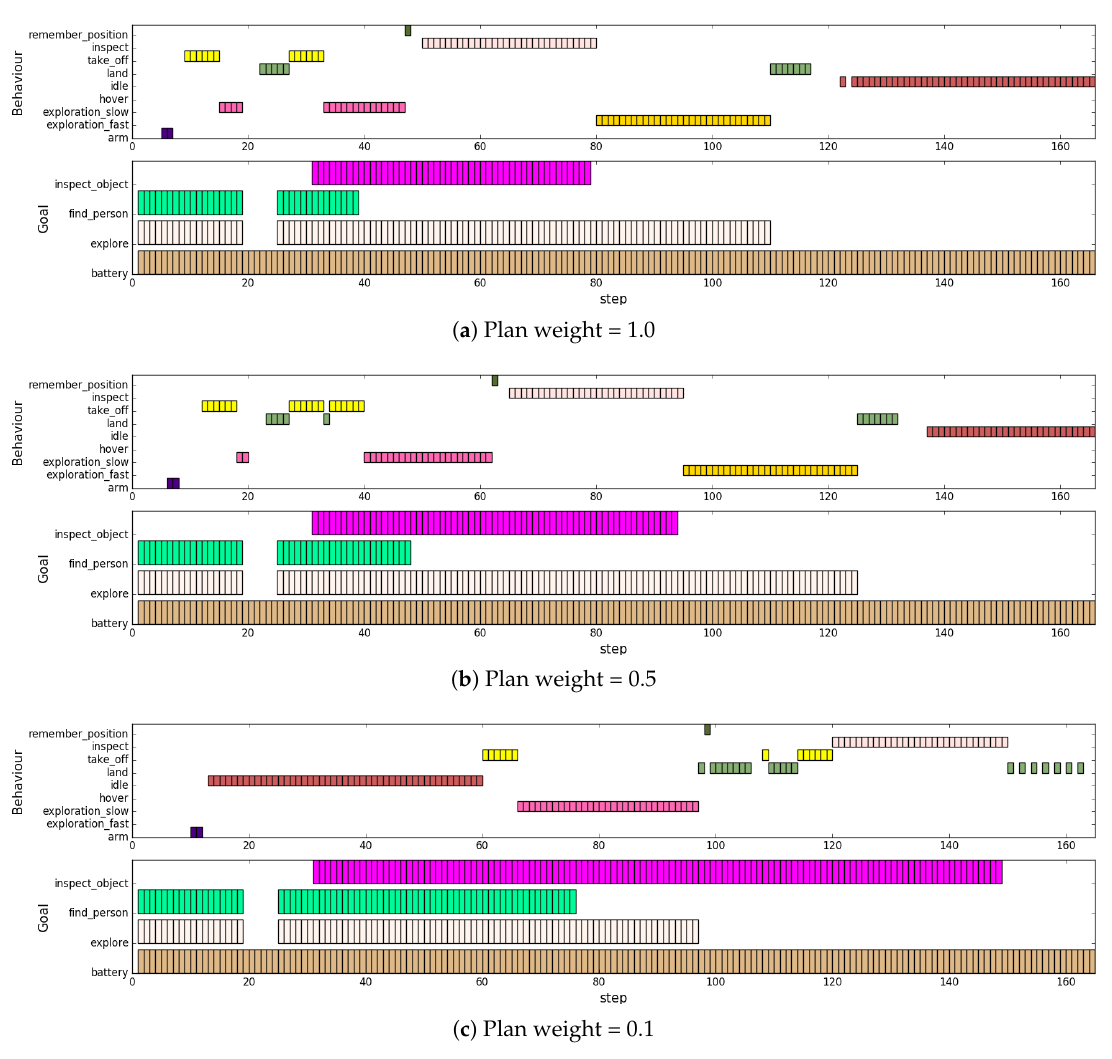
Figure 14. Selected behaviours and enabled goals over time ( step characteristic symbolic planning influences specified by